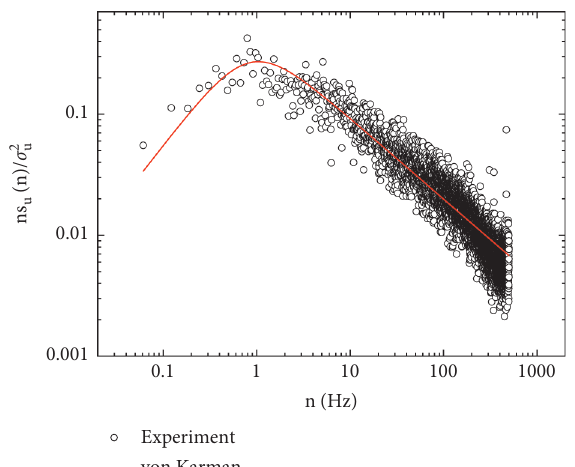
Figure 3: Turbulence wind power spectrum.